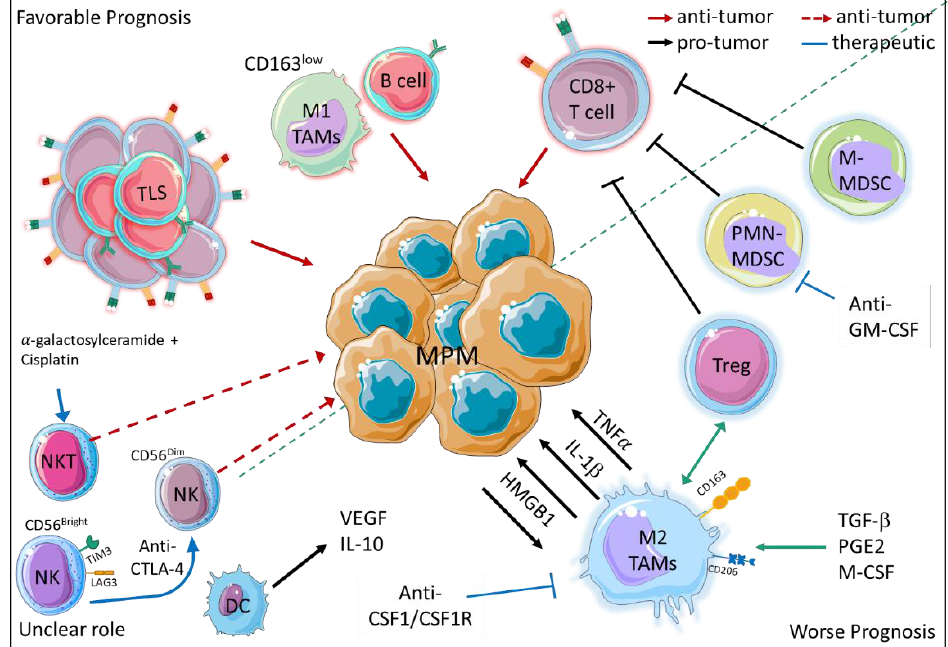
Figure 2. Immune cell infiltrate impacts MPM outcome. On the upper left corner, the main immune cell populations associated with better outcomes are depicted, whereas on the lower right corner, the pro-tumoral and immunosuppressive immune cell populations are shown. The immune cells with a putative albeit not yet proven anti-tumor activity are indicated in the lower left corner. (Solid red arrows: anti-tumor activity, dashed red arrows: putative anti-tumor activity, black arrows: pro-tumor activity, blue arrows and inhibition arrows: putative therapeutic approaches. TLS, tertiary lymphoid structure; TAM, tumor associated macrophage; PMN-MDSC, polymorphonuclear- myeloid-derived suppressor cells; M-MDSC monocytic-myeloid-derived suppressor cells; NK, Natural killer cells; NKT, Natural killer T cells; TAM, Tumor associated macrophages; DC, dendritic cells; Treg, T regulatory cells; IL-1 β , Interleukin 1 Beta; IL 10, Interleukin 10; HMGB1, high mobility group box 1; PGE2, Prostaglandin 2; M-CSF, Macrophage colony stimulating factor; TNF α , Tumor necrosis factor alpha; TGF β , transforming growth factor beta; VEGF, vascular endothelial growth factor.) The figure was partly generated using Servier Medical Art, provided by Servier, licensed under a Creative